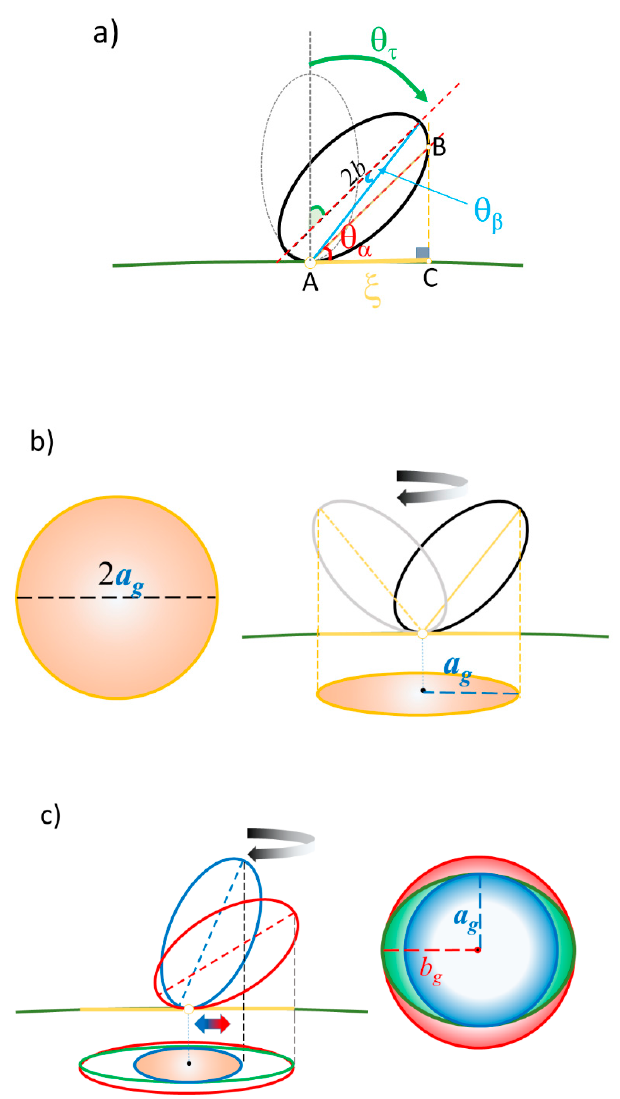
Figure 10. A sketch of the side view of a rotating prolate. ( a ) The tilting of a prolate over the nano-gold surface and approximation for radius ( AC ) of the circular plane over the nano surface. Here, θ α is a tangential angle between prolate axis and the surface line, and the tilting angle of a prolate against surface plane is given by an angle θ τ . ( b ) A rotational motion of a prolate with a fixed contacting point, resulting in a circular occupied space over the surface. ( c ) A gyration motion of a prolate with a movable contacting point and tilting angle θ τ , resulting in an oval (in green) occupied space with axial length of a g (blue circle) and b g (red circle).